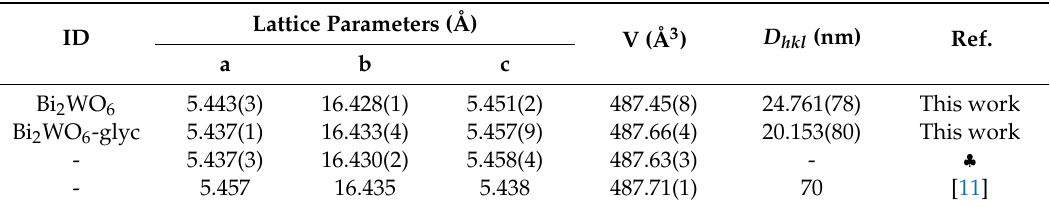
Table 1. Lattice parameters (a, b, and c), direct unit cell volume, and crystallite size ( D hkl ) of Bi 2 WO 6 and Bi 2 WO 6 -10 crystals and reported values by